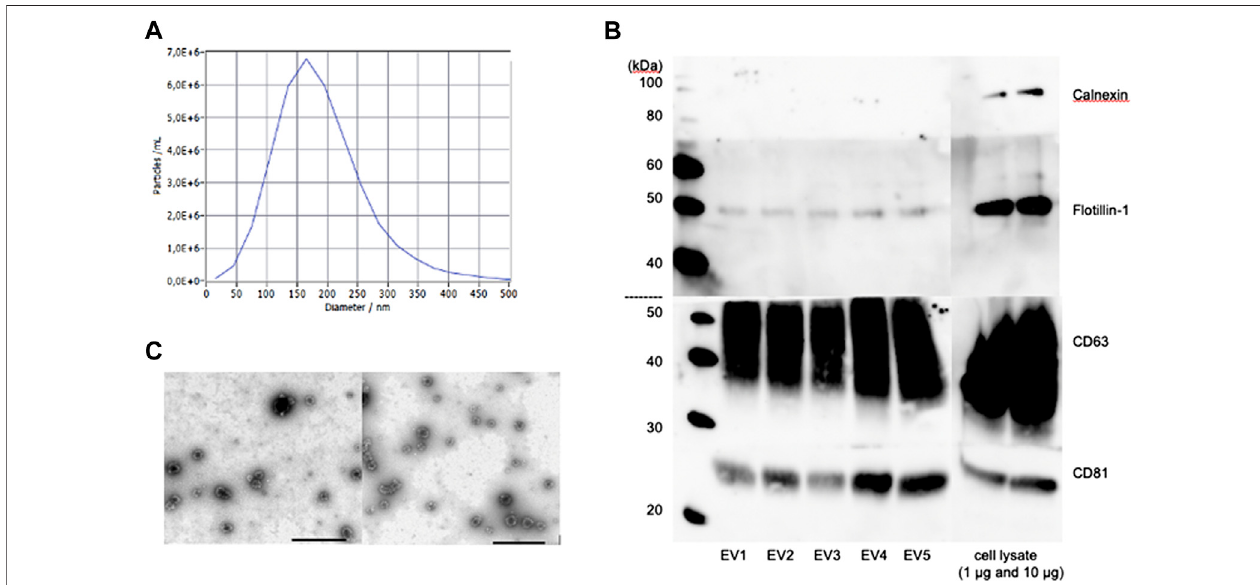
FIGURE 1 | Characterization of MSC-derived EVs of young and aged donors. (A) Nanoparticle Tracking Analysis of one representative sample. (B) Western Blot analysisofCD63,CD81,Flotillin-1and Calnexin indifferent MSC-EVsamples. (C) RepresentativeTEMimages ofyoungMSC-EVs (left)and agedMSC-EVs (right), scale bar: 1,000